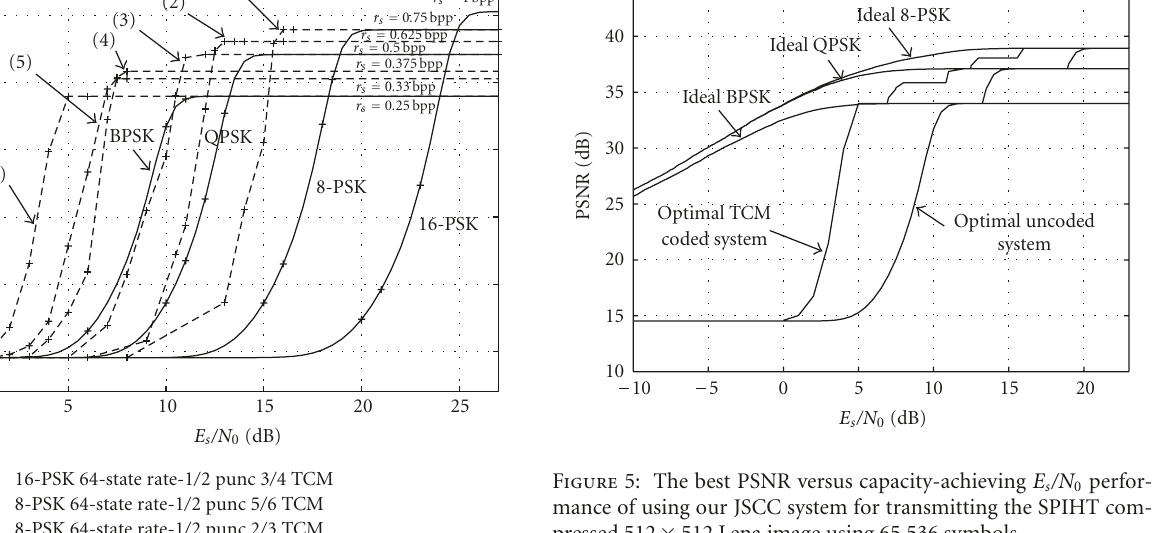
512 Lena im- (cid:0)